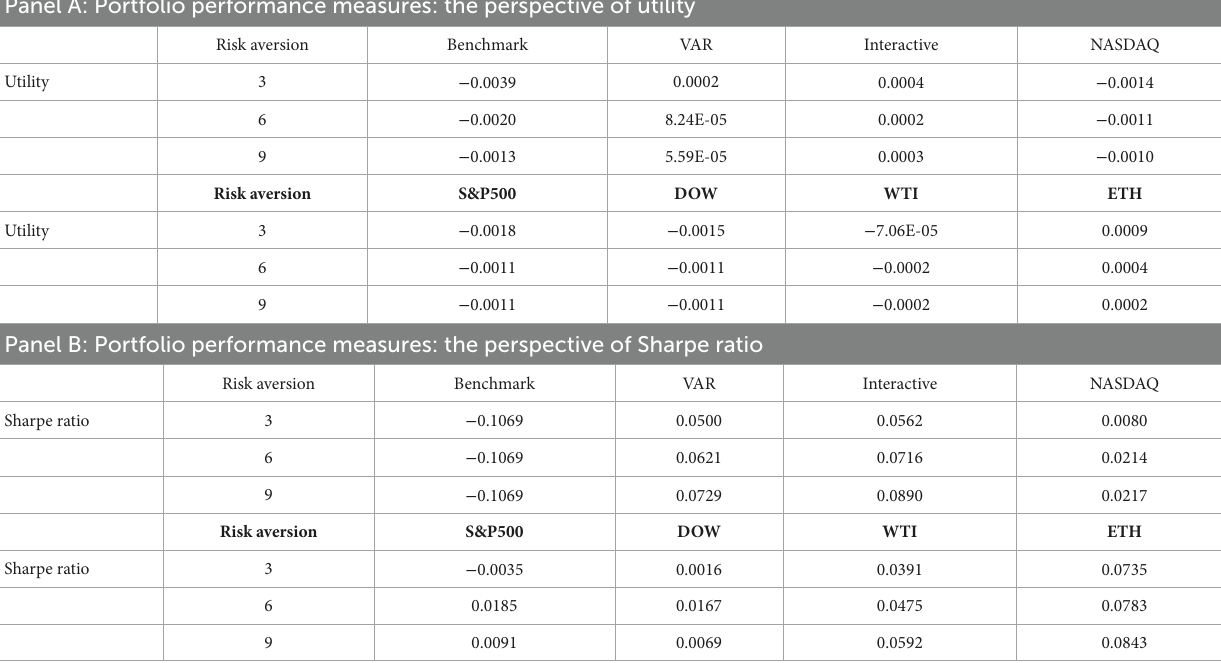
VAR Interactive NASDAQ